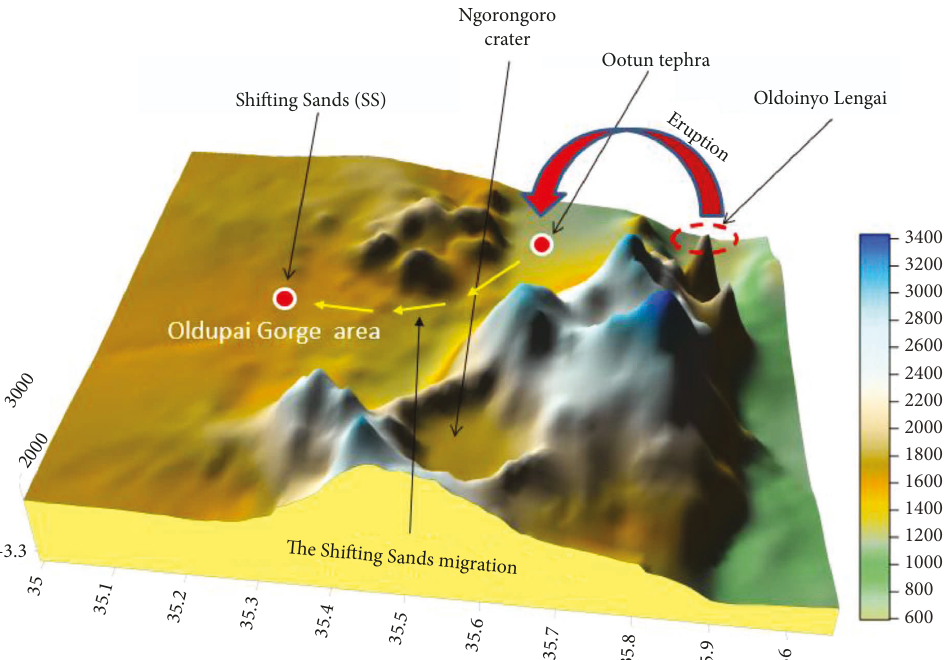
Figure 15: A model of the study site was generated from the Shuttle Radar Topography Mission (SRTM) digital elevation dataset collected in 2000, using Surfer software version 16.